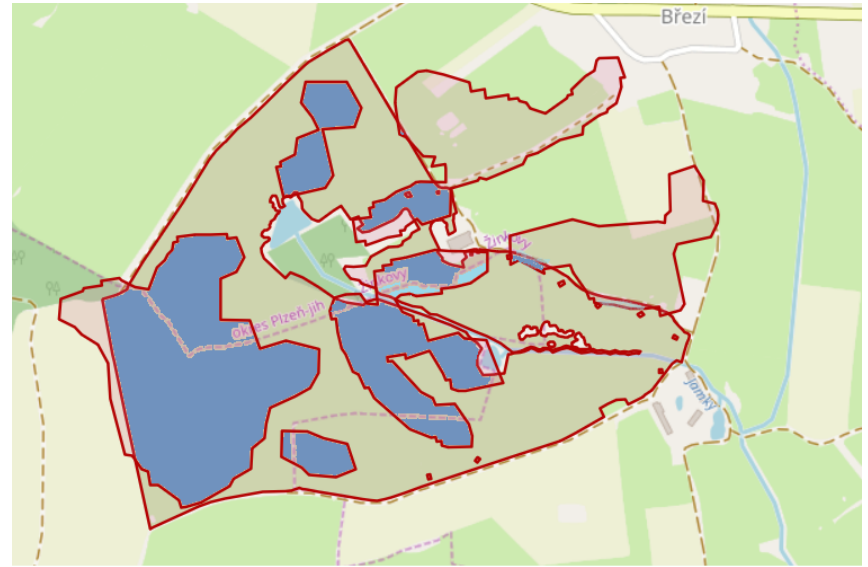
Figure 9. Erosion land zones of a field.